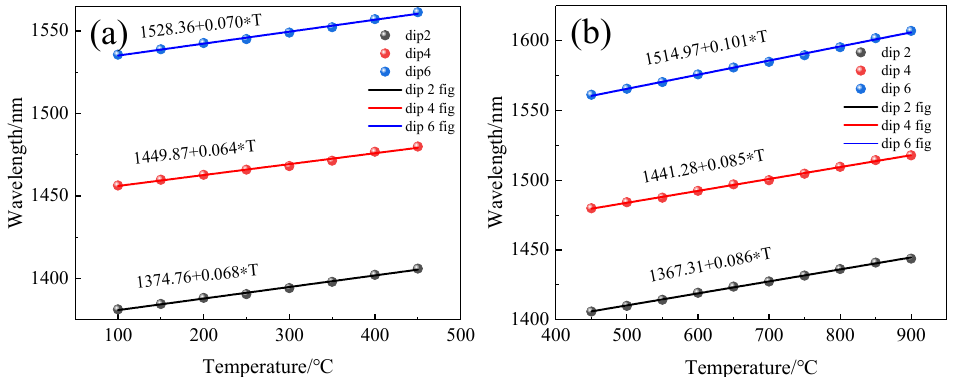
Figure 13. Temperature sensitivity of the MI structure with different dips. ( a ) low-temperature re- gion (100 °C~450 °C); ( b ) high-temperature region (450 °C~900 °C). (100 ◦ C~450 ◦ C); ( b ) high-temperature region (450 ◦ C~900 ◦